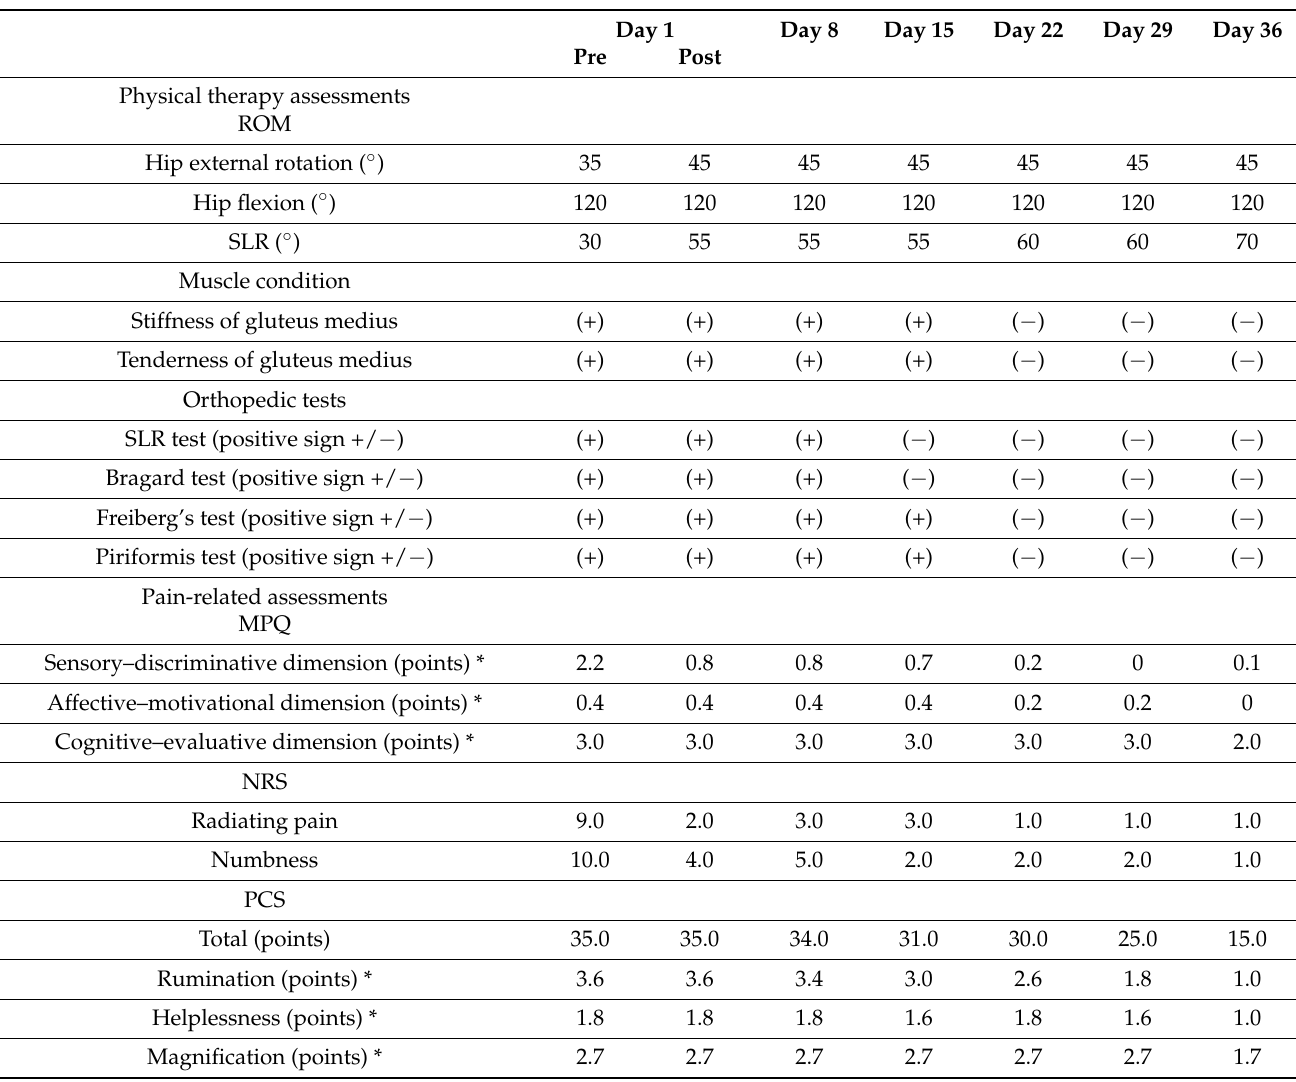
Table 2. Results of physical therapy and pain-related